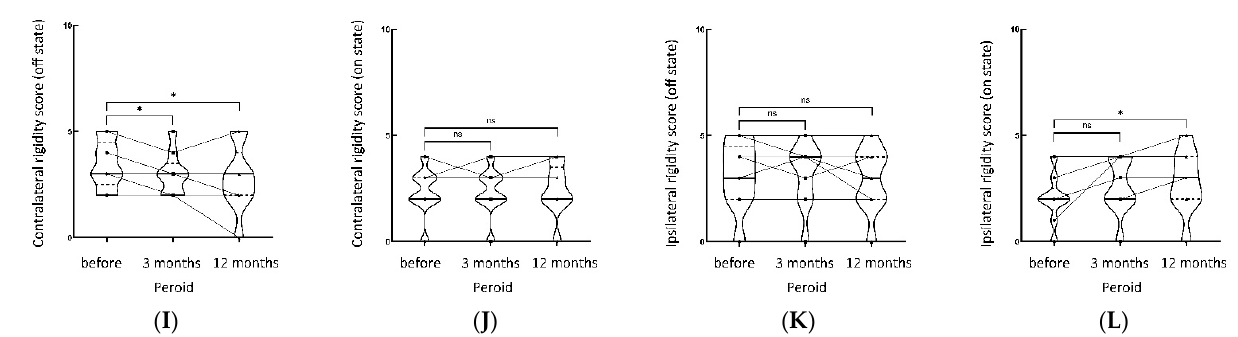
tralateral and ipsilateral limbs pre-operation, 3 months, and 12 months post-operation, respectively. ( A ) Contralateral tremor score (off state), ( B ) contralateral tremor score (on state), ( C ) ipsilateral tremor score (off state), ( D ) ipsilateral tremor score (on state). ( E ) Contralateral bradykinesia score (off state), ( F ) contralateral bradykinesia score (on state), ( G ) ipsilateral bradykinesia score (off state), ( H ) ipsilateral bradykinesia score (on state). ( I ) Contralateral rigidity score (off state), ( J ) contrala- teral rigidity score (on state), ( K ) ipsilateral rigidity score (off state), ( L ) ipsilateral rigidity score (on state). ** p < 0.01, * p < 0.05, NS not significant.